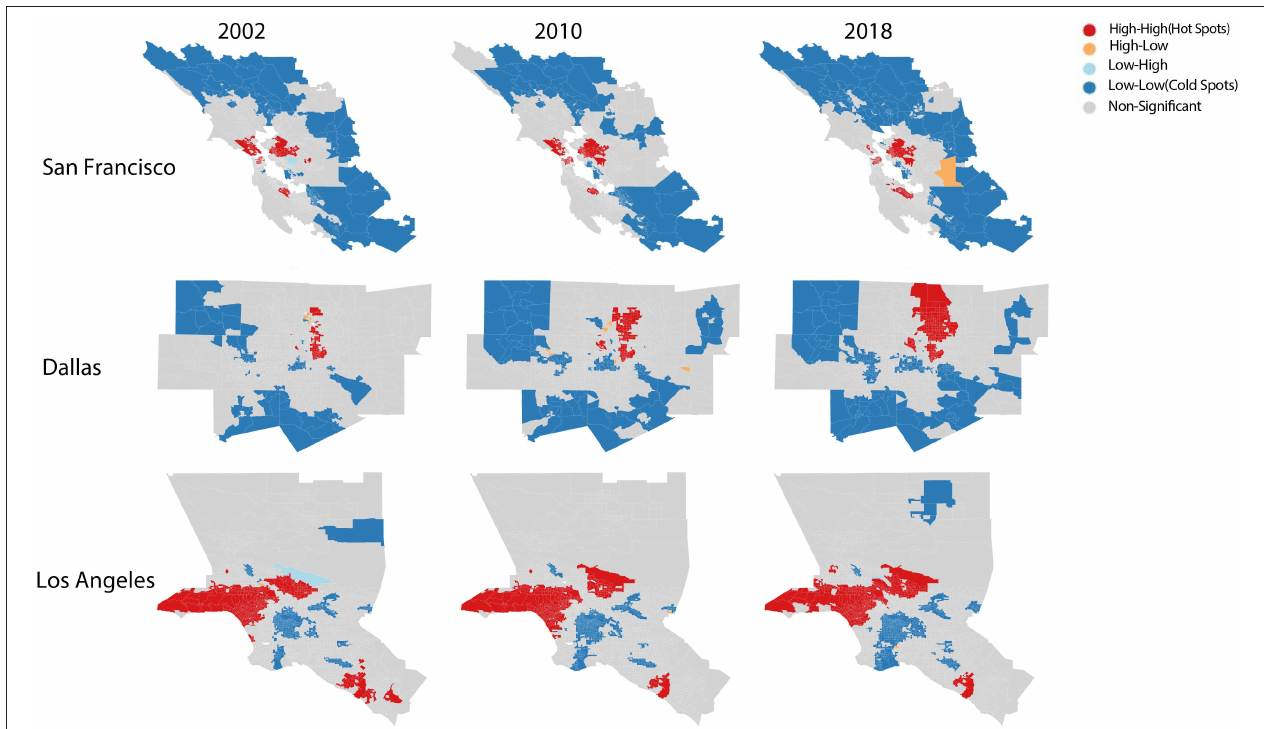
FIGURE 4 | Local spatial autocorrelation significant areas map.